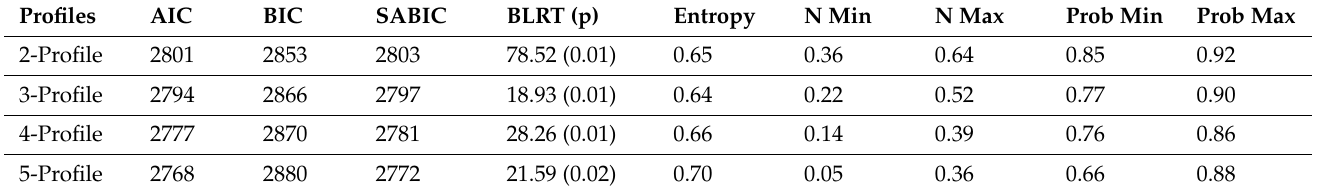
Table 2. Model fit indices, class size, and class probabilities for FFM-only latent profile